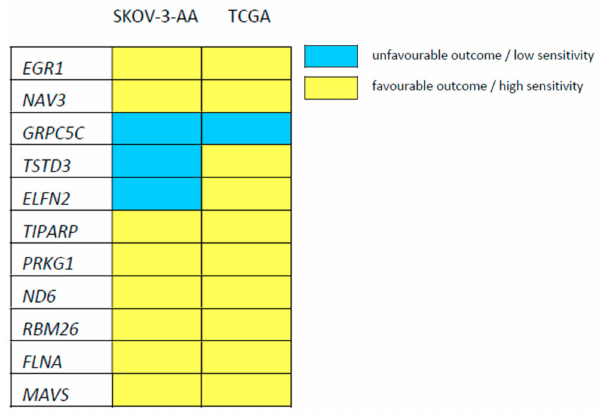
Figure 4. Heatmap indicating the relationship between low expression of the indicated genes and sensitivity / outcome, favourable (low cisplatin EC 50 in SKOV-3-AA cells or prolonged survival of cisplatin-treated patients, indicated in yellow) or unfavourable (high cisplatin EC 50 in SKOV-3-AA cells or reduced survival of cisplatin-treated patients, indicated in blue), based on the comparison of gene expression between SKOV-3-AA and EV- or PEA-15DD-transfected variants and TCGA data.